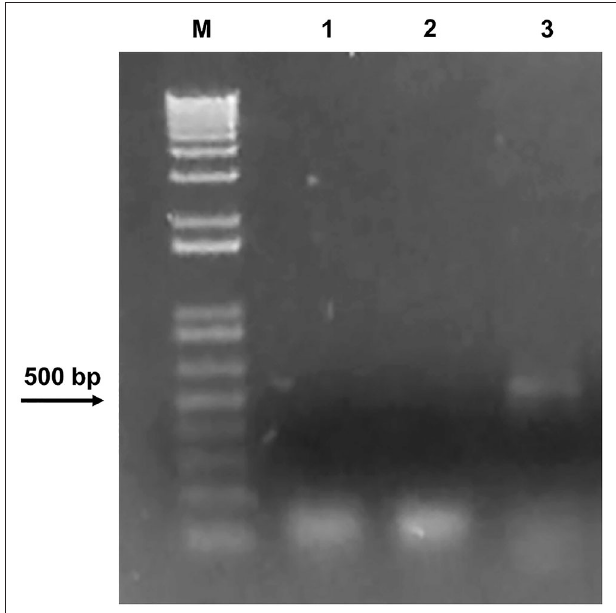
FIGURE 8 | Agarose gel electrophoresis showing DNA only in the untreated stone. M: DNA marker (1Kb Plus DNA Ladder Biolabs ® ). PCR was carried out using 1: water as a negative control; 2: DNA extracted from the Preventol RI-80 0.3@MSN-treated stone; 3: DNA extracted from the untreated stone.